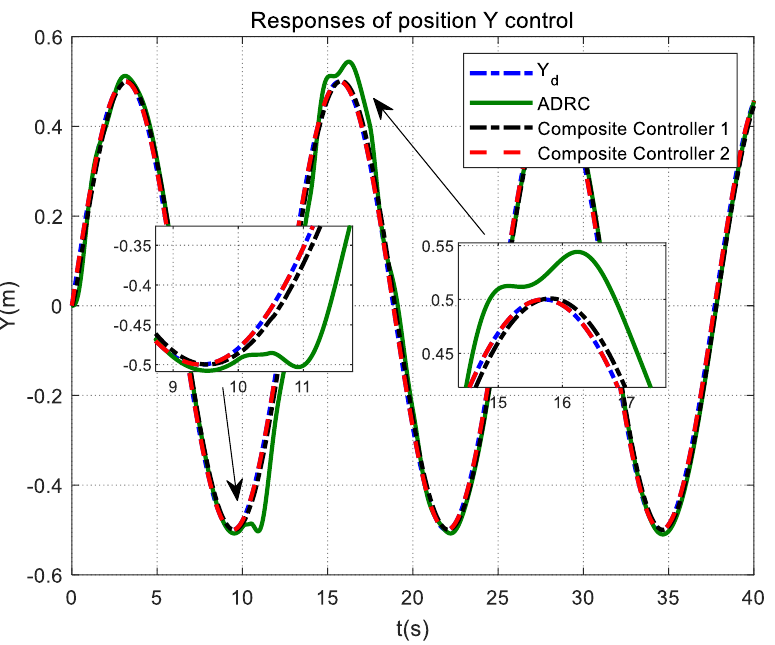
Figure 9. Responses of position Y control for QUAV under actuator constant fault and disturbance condition.